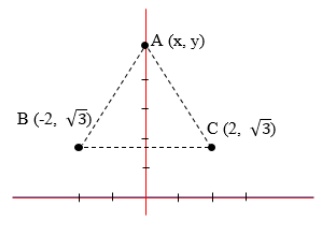
Figure 4. Problem Figure 4. Problem P2 .